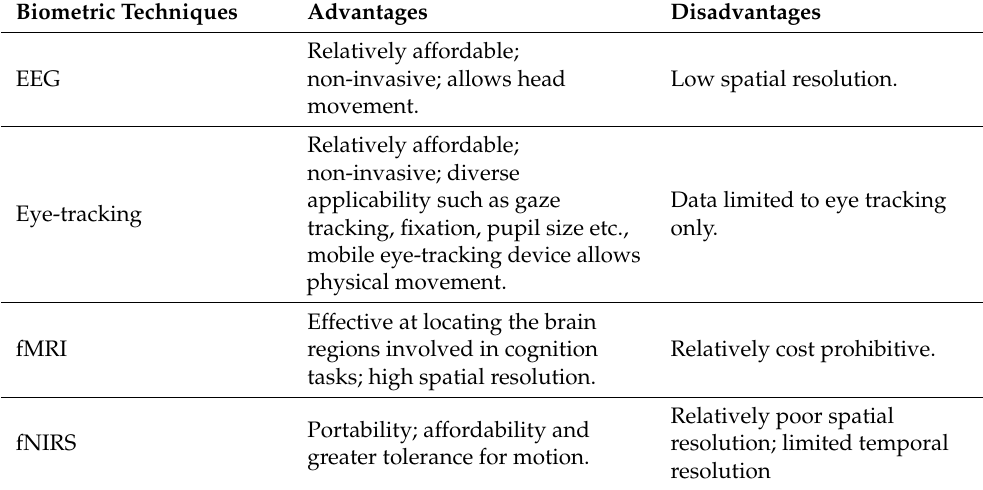
Table 2. Advantages and disadvantages of principal biometric